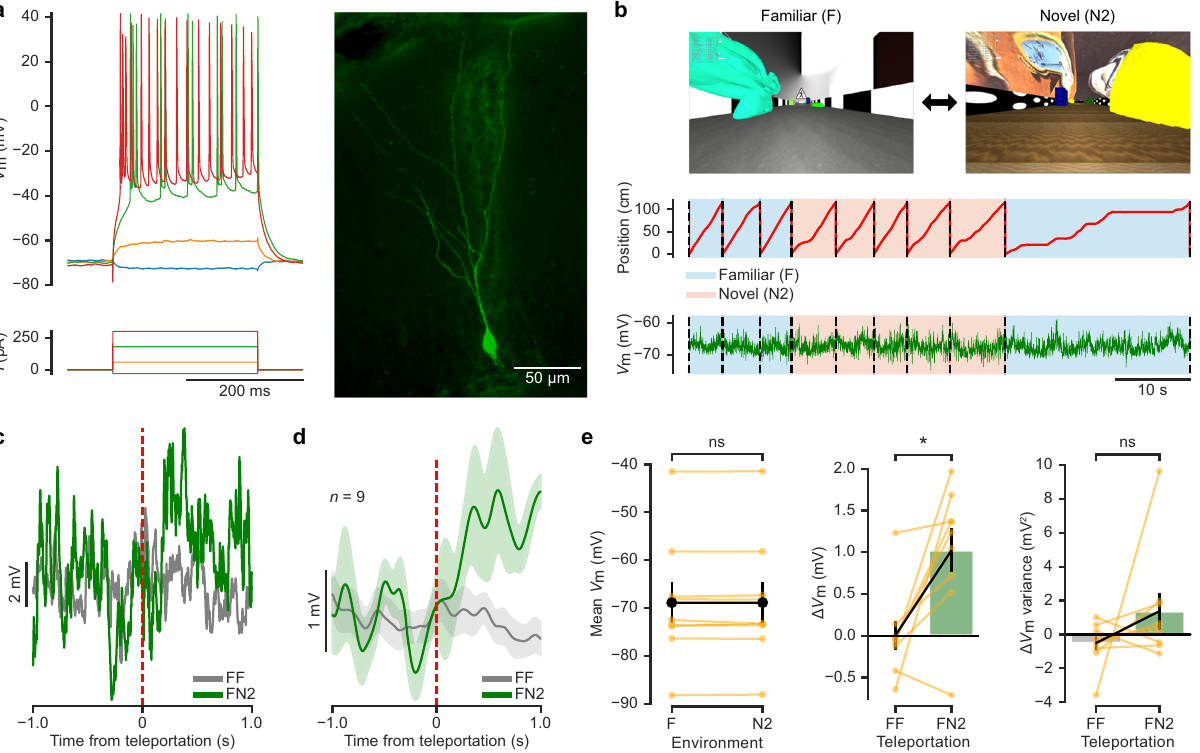
Fig. 2 Granule cells transiently depolarise in response to saliency. a Example recording from a granule cell (from 73 independent recordings with